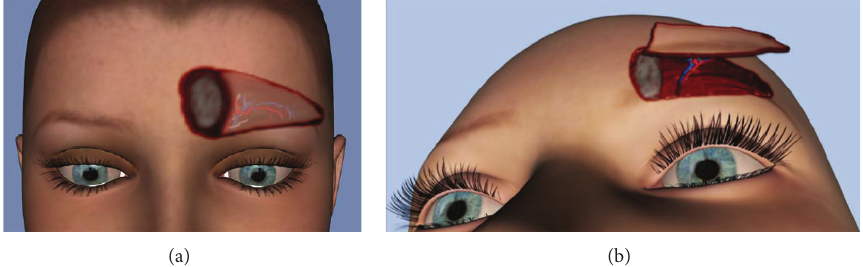
Figure 1: 3D illustration of surgical technique: the defect is outlined in an oval area, and a triangular flap including the entire hairy portion of the remaining eyebrow is incised (a); the flap is advanced toward the difect pedicled on a perforator vessel (b).